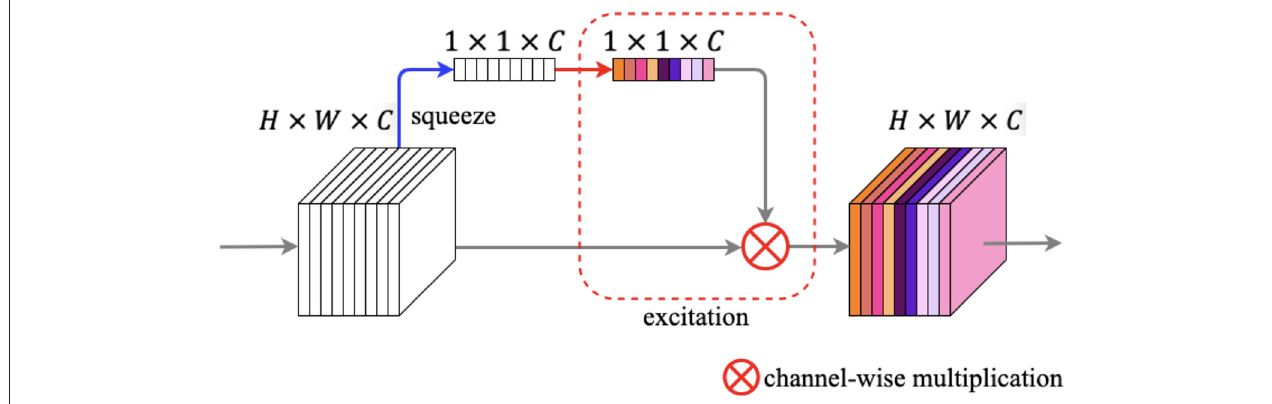
FIGURE 8 | Squeeze and excitation block. The blue arrow denotes squeeze operation, while the red rounded rectangle denotes excitation operation.